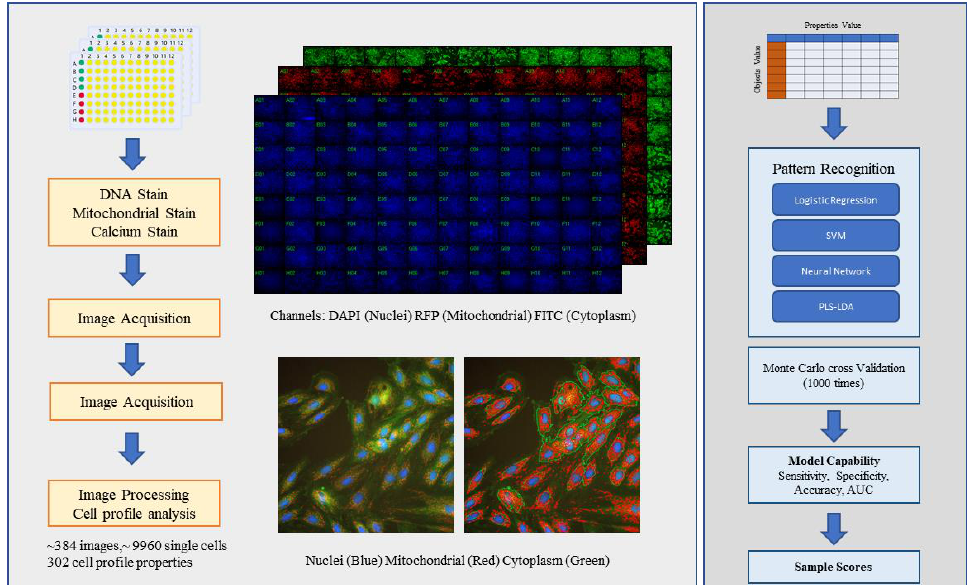
Figure 1. High-throughput imaging methodology. ( A ) Schematic representation of high-throughput imaging methodology. Cells are grown in flat-bottom plates and a compound is added to the desired wells. After incubation, cells are stained with the dye mix (Hoechst 33342, tetramethyl rhodamine methyl ester (TMRM), and Calcein-AM). Image acquisition is by a commercial instrument and four images were collected per channel per well. The image dataset is then subjected to image and data processing by CellProfiler. ( B ) Schematic representation of the image data analysis pipeline. Single-cell images were created for 302 cell properties. The cells treated with Dox were labeled as “positive” and the non-treatment cells were labeled as “negative.” A pattern recognition model was built by four algorithms and validated by Monte Carlo cross-validation. The sample scores were calculated by the classification model to represent the cell morphologies.